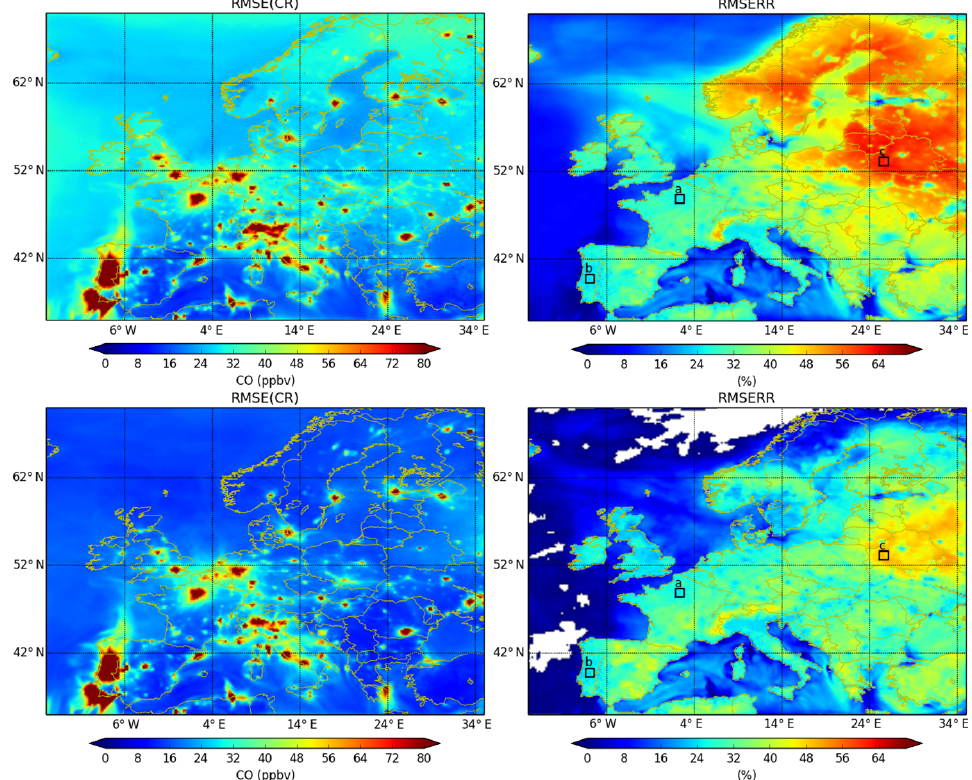
Figure 11. Top: root mean square error (RMSE), units ofppbv, between CR and NR (left panel), and its corresponding reduction rate RMSERR in % (right panel), keeping the systematic error. Bottom: same as top panel but calculating the RMSE after removing the systematic error. The labels on each panel are longitude in degrees ( x axis) and latitude in degrees ( y axis). The three squares in the two right panels represent the locations for the three time series shown in Fig. 13. Red/blue colors indicate relatively high/low values in the RMSE/RMSERR.